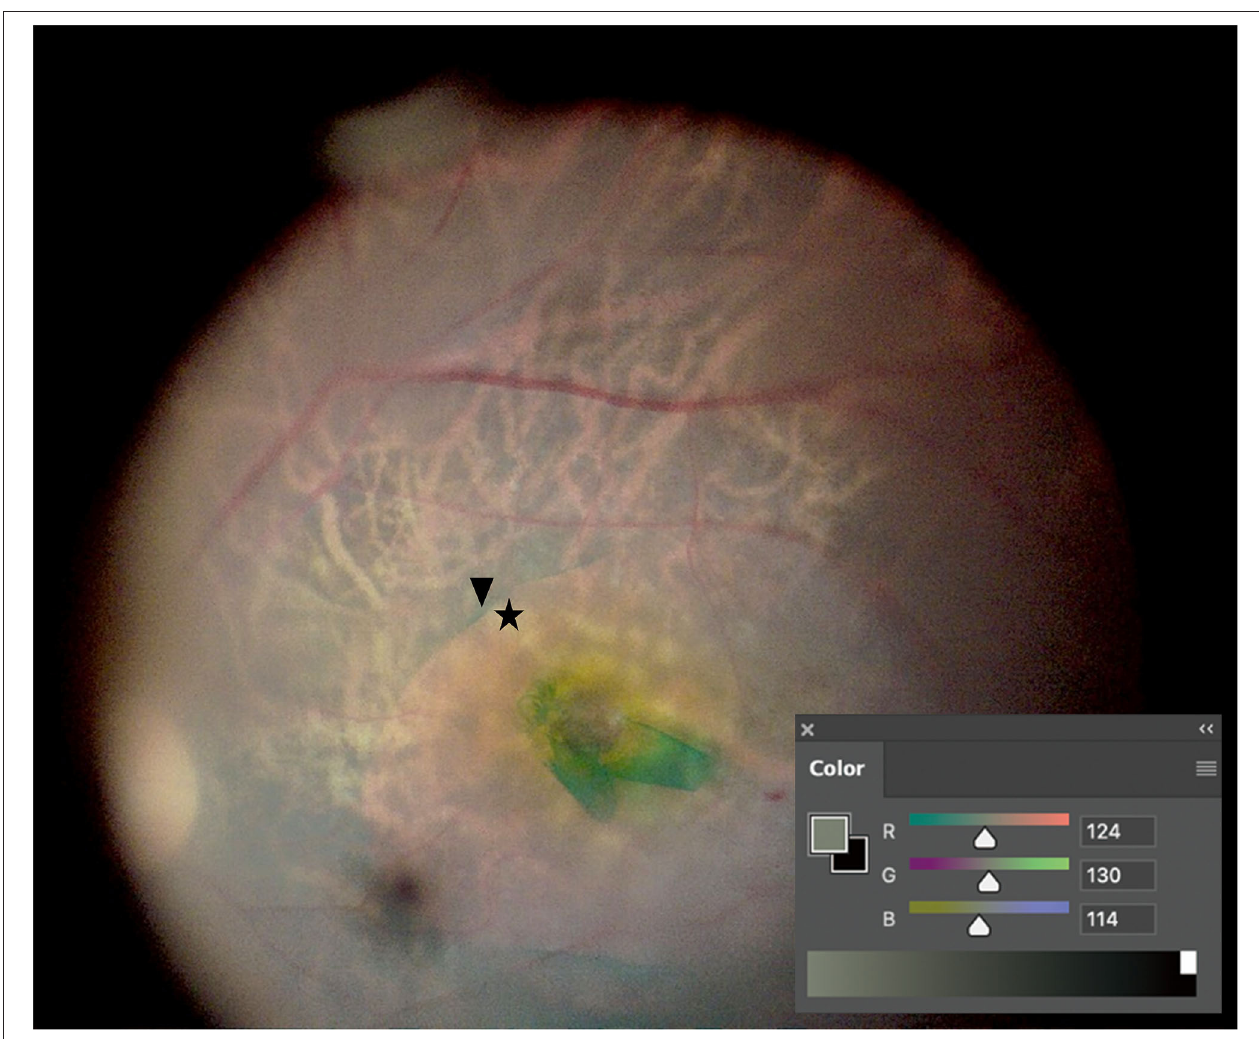
FIGURE 1 | Color contrast ratio (CCR) measurement. After internal limiting membrane (ILM) peeling, retinal images were captured. CCR was measured by comparing RGB values between the indocyanine green-stained area (arrowhead) and the ILM-peeled area (asterisk) using the Eyedropper tool of